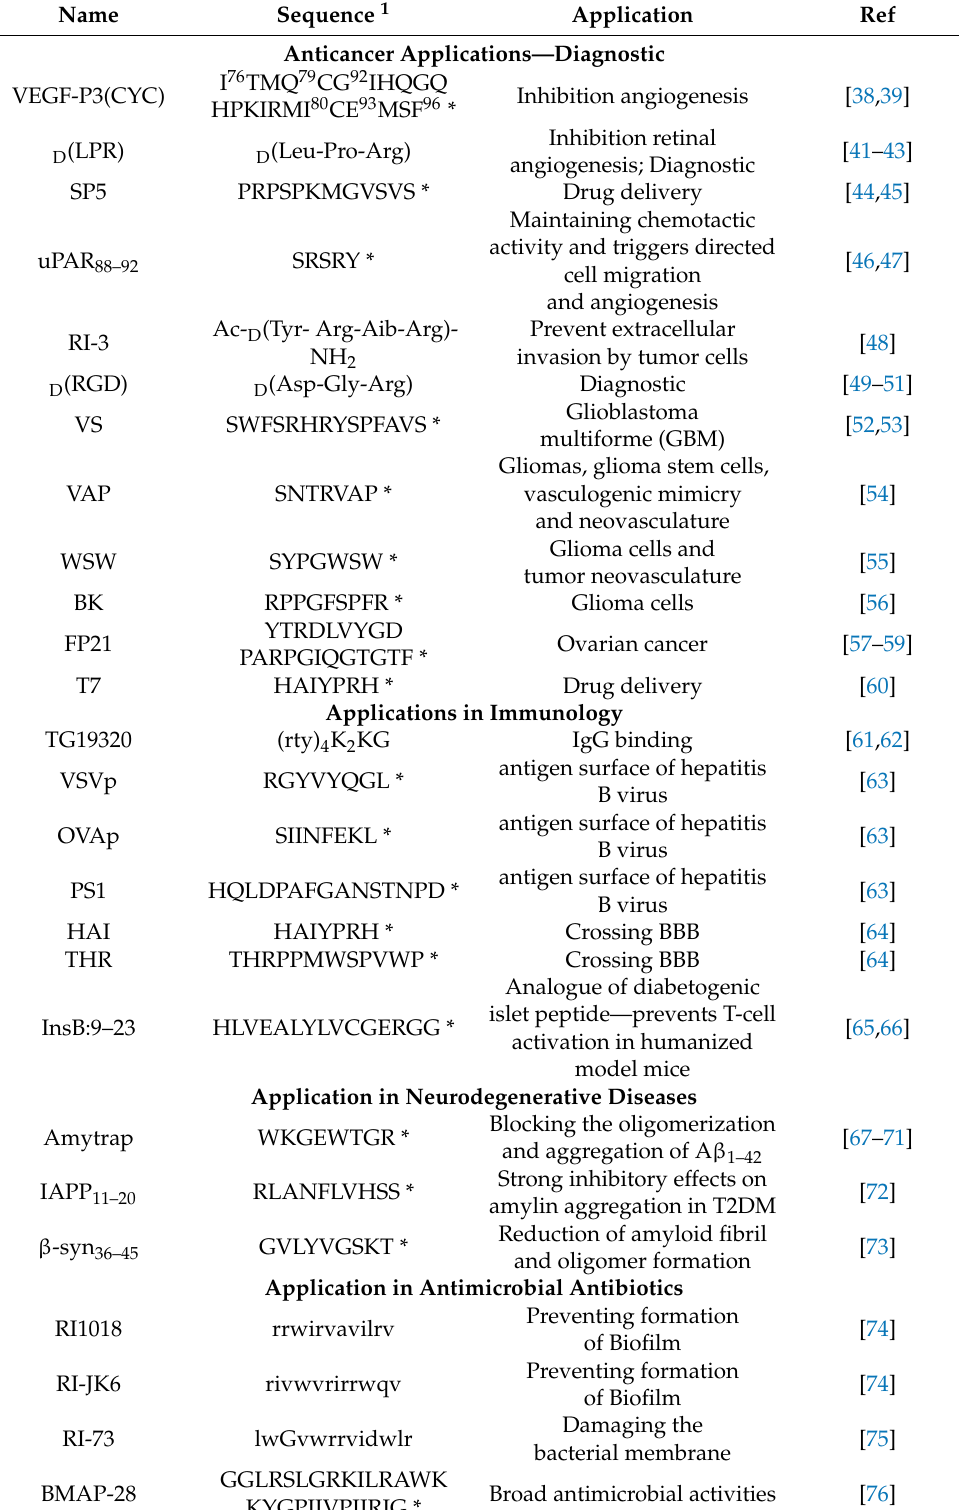
Table 1. Names, peptide sequences reported in the review and their